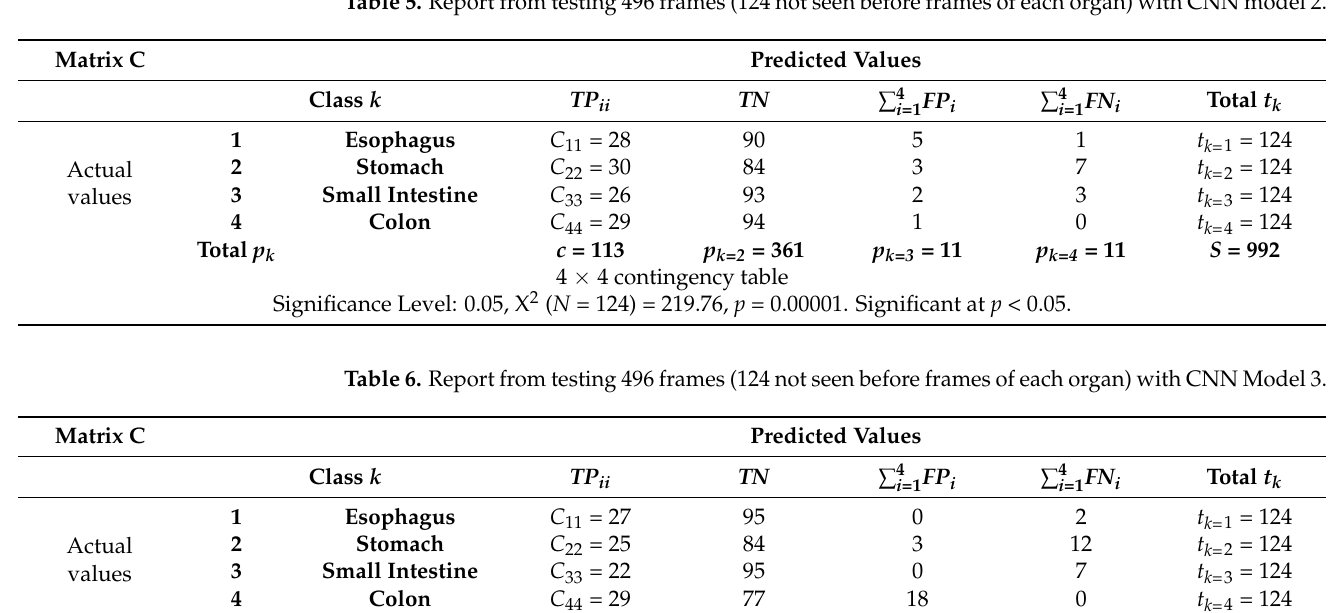
Table 5. Report from testing 496 frames (124 not seen before frames of each organ) with CNN model 2.